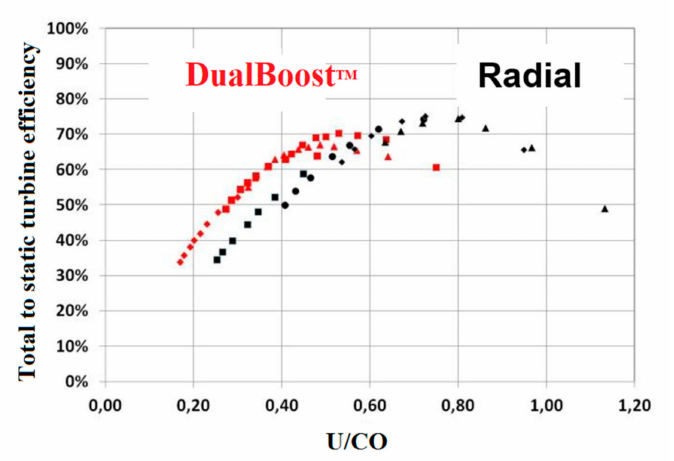
Figure 1. Comparison of turbine total to static e ffi ciency vs. blade-to-gas-speed ratio between a radial and axial